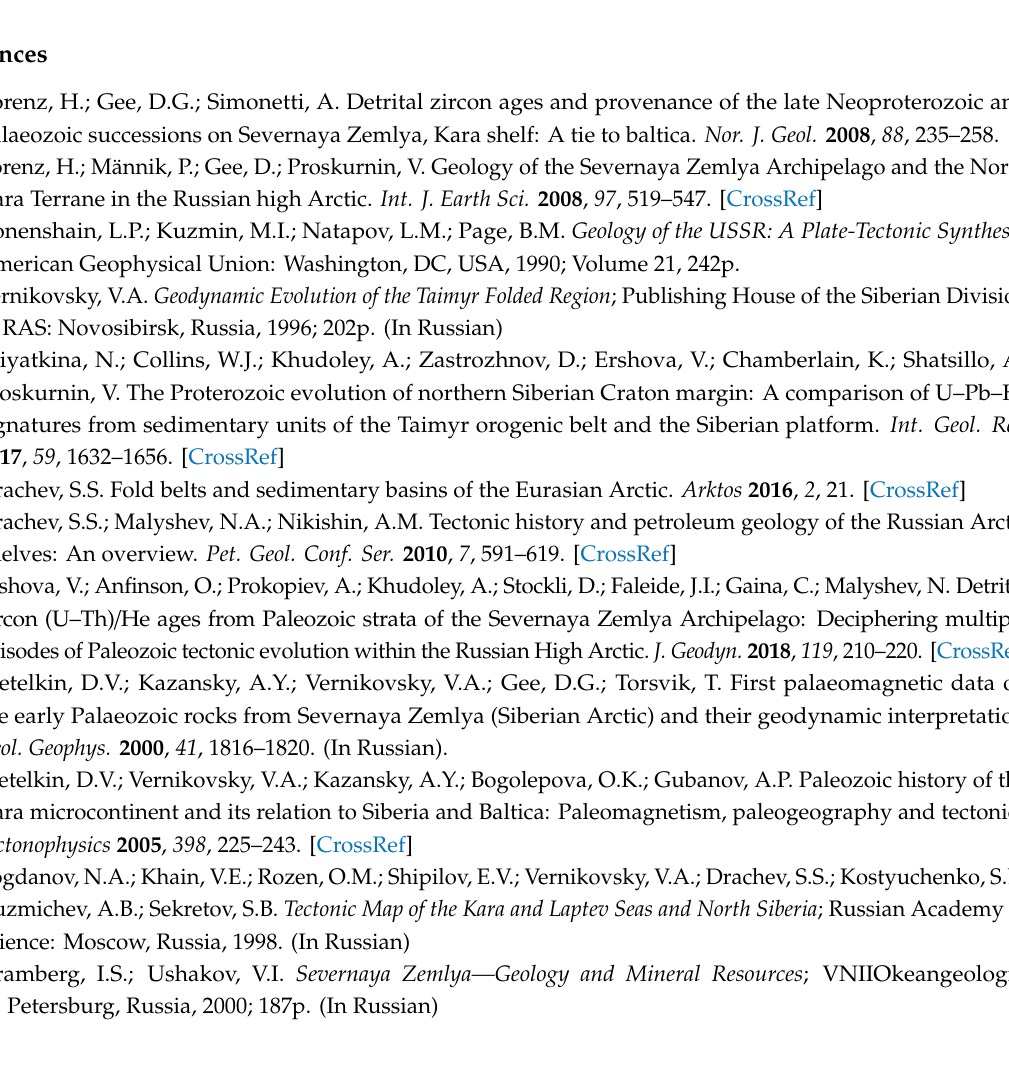
Table S1: Results of U–Pb dating of detrital zircons; Table S2: Lu–Hf data for dated detrital zircons; Table S3: Data reporting Information for LA-ICP-MS U–Th–Pb